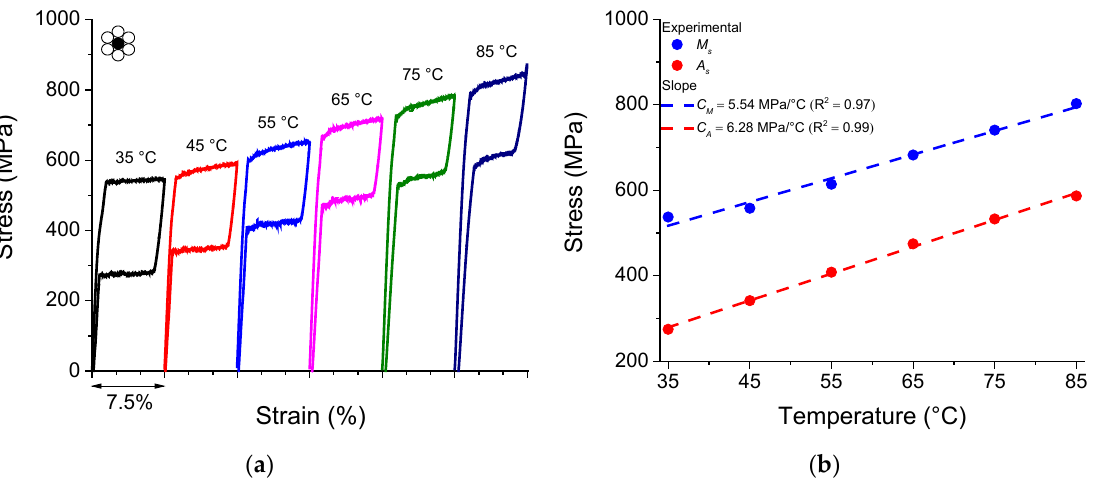
Figure 4. ( a ) Superelastic stress vs. strain response of the NiTi SMA core wire for different temper- atures. ( b ) Phase diagram of NiTi SMA core wire.